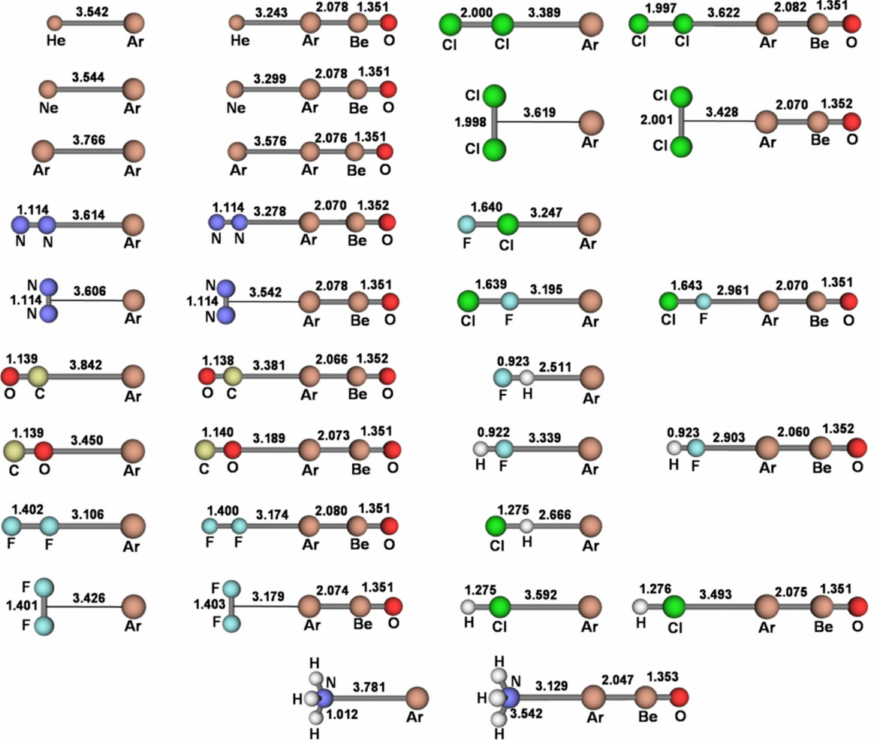
Figure 2. MP2/aVTZconnectivities and bond distances (Å) of the L Ar and L -ArBeO ( L = He, Ne, Ar, N 2 , CO, F 2 , Cl 2 , ClF, HF, HCl, NH 3 ).